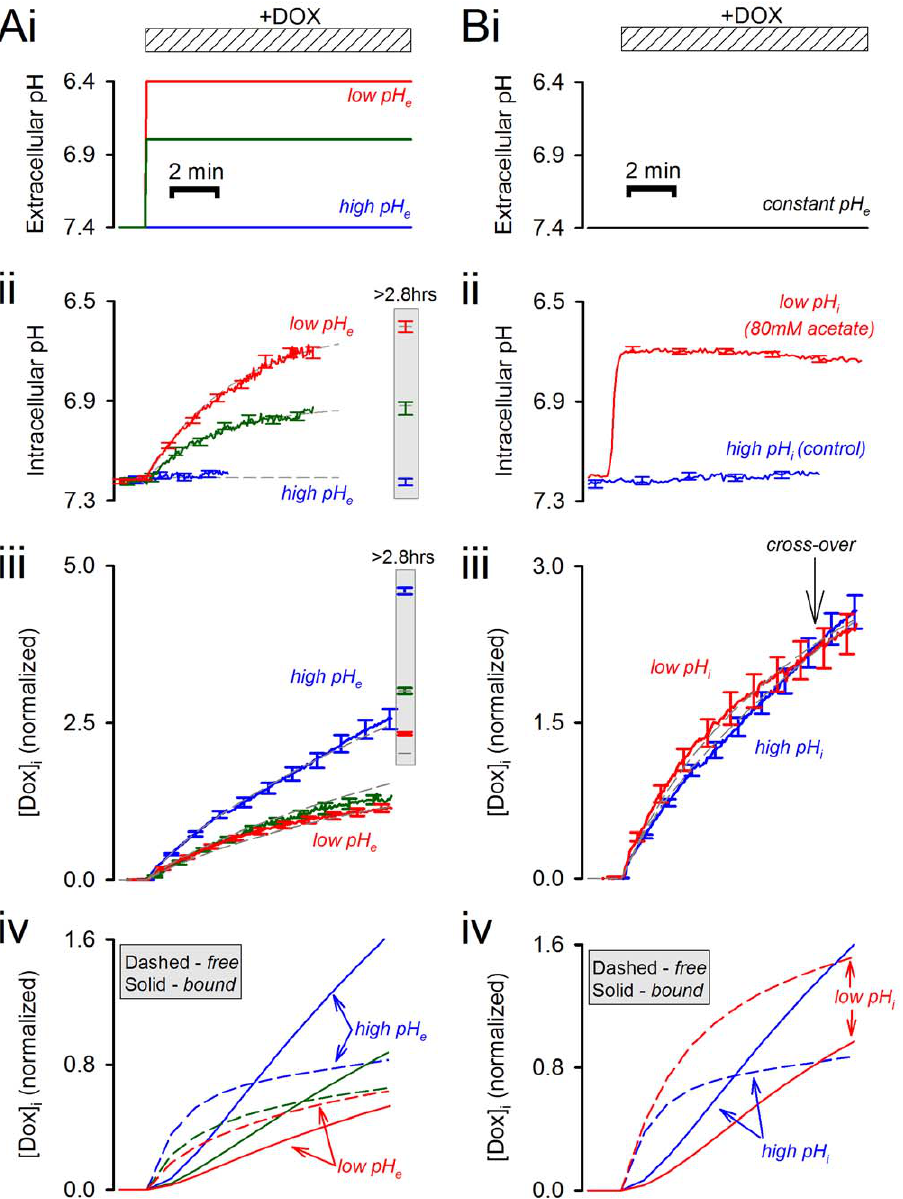
Figure 2. Effect of changing extracellular and intracellular pH on doxorubicin uptake. Time-courses show the average ( 6 SEM) of at least 25 cells. (A) (i) Extracellular pH was changed by switching to superfusates titrated to pH 6.8 or 6.4, simultaneously with the application of 50 m M doxorubicin. (ii) Intracellular pH measured in separate experiments using carboxy-SNARF-1. (iii) Intracellular doxorubicin, normalized to its extracellular signal. Inset shows intracellular fluorescence at steady state, attained after 2.8 hours of drug-exposure. (iv) Simulated doxorubicin time- courses. (B) (i) Intracellular pH was reduced to 6.7 at constant extracellular pH by superfusing cells with 80 mM acetate in the presence of the Na + /H + exchange inhibitor, dimethyl amiloride (DMA; 30 m M). Doxorubicin was applied once pH i attained a steady-state. (ii) Intracellular pH measured with carboxy-SNARF-1. (iii) Intracellular doxorubicin fluorescence, showing the cross-over of time-courses for pH i =7.2 and 6.7. (iv) Simulation of doxorubicin-time-courses.